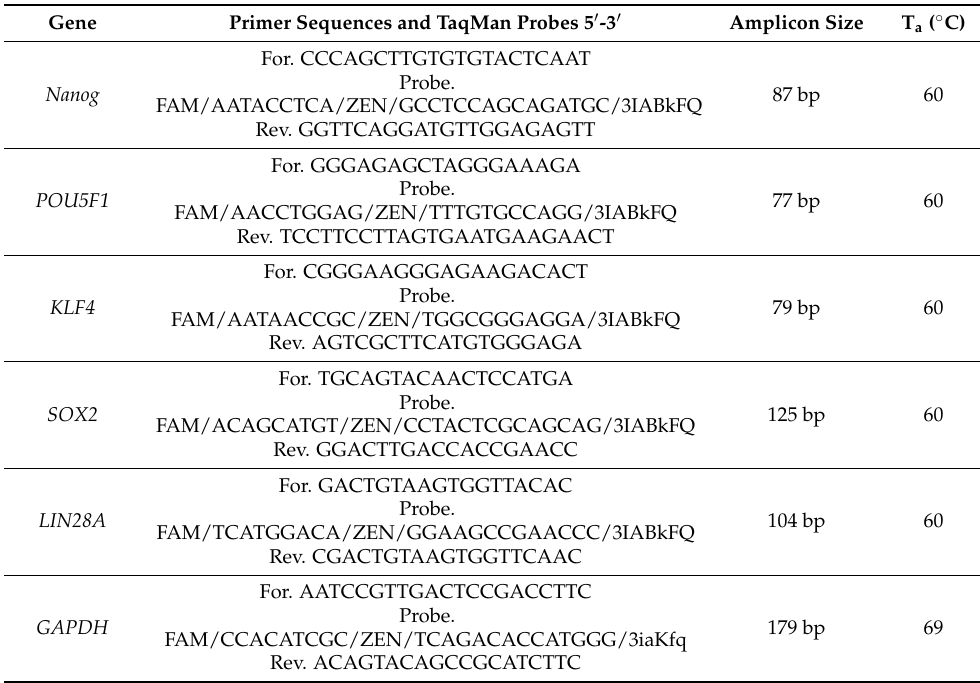
Table 2. Detailed list of primer and probe sequences, with the amplicon size and annealing tempera-